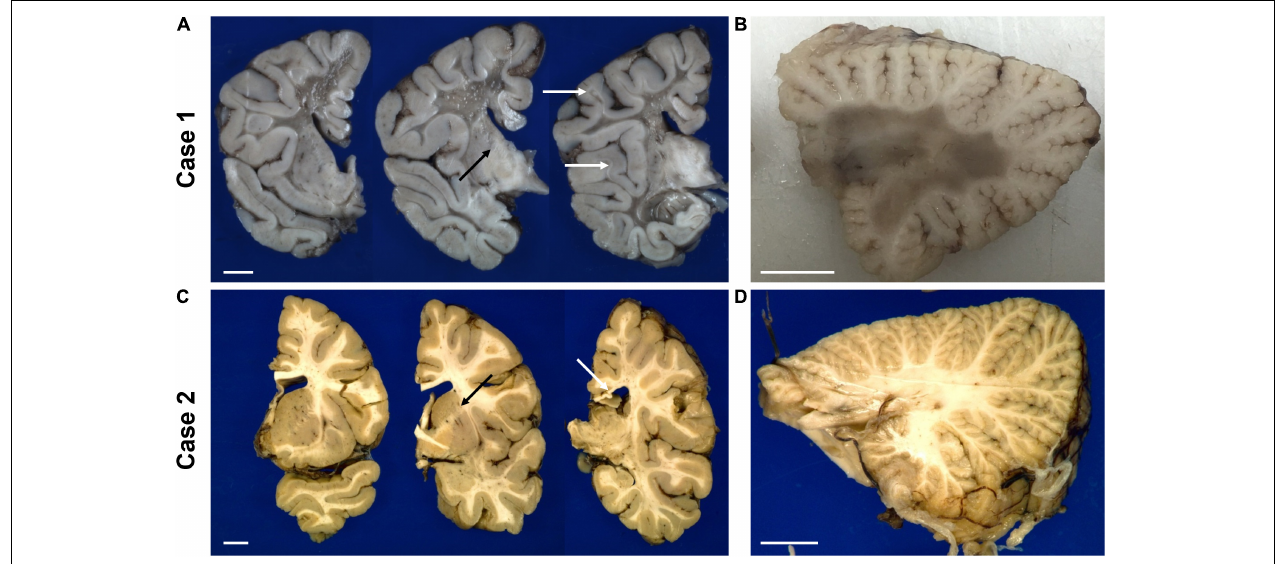
FIGURE 4 | Representative gross photographs of coronal sections of the forebrain (A,C) and sagittal sections of the cerebellum (B,D) of the untreated case 1 ( top row ) and transplanted case 2 ( bottom row ). The white arrows in panel (A) indicate examples of residual white matter between preserved cortical ribbon and end-stage white matter. The white arrow in panel (C) points to thinned posterior corpus callosum. The black arrow in panels (A,C) indicate the internal capsule. The scale bar is set to 1 cm for each